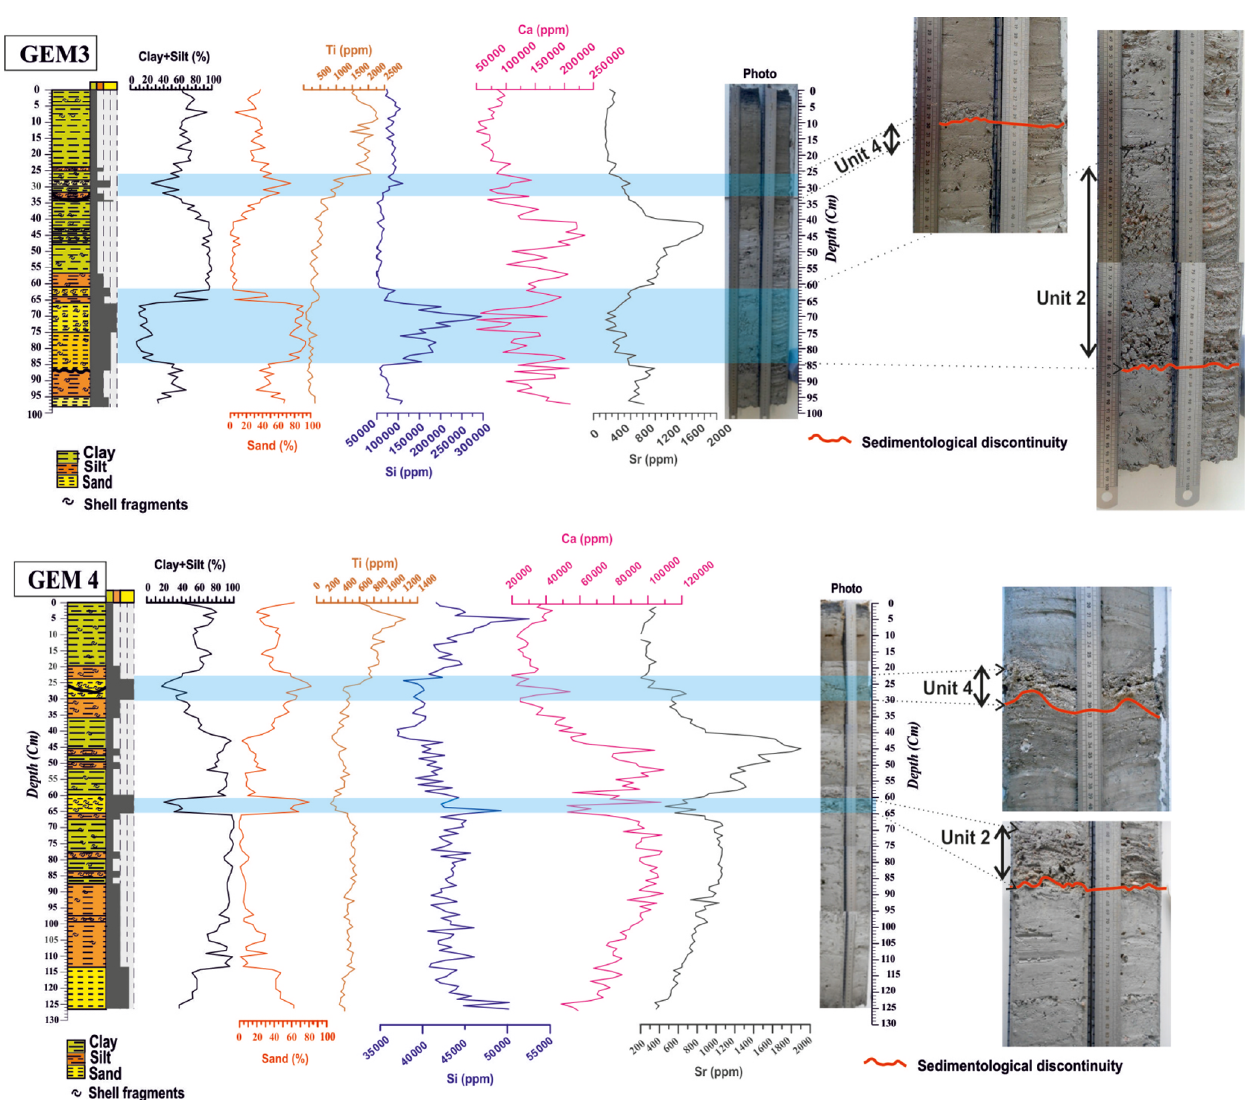
Figure 2. Stratigraphic log and grain size results of GEM3 and GEM4 cores compared to the results obtained from the XRF records (titanium, silicon, calcium, and strontium) vs.